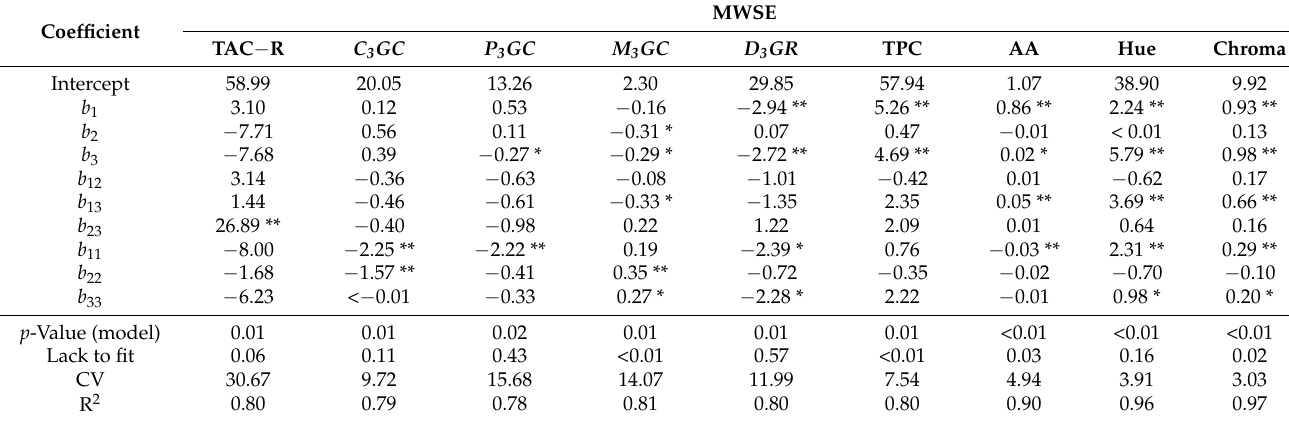
Table 3. Regression coefficients and analysis of variance for chemical properties of